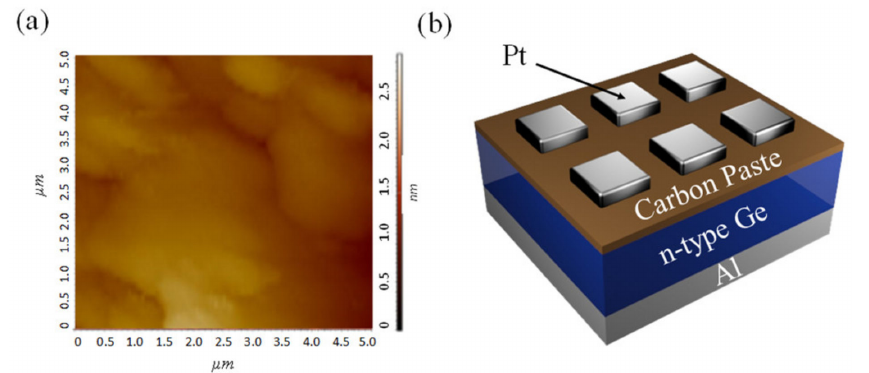
Figure 1. ( a ) Atomic force microscopy (AFM) image of a carbon paste (CP) film and ( b ) device structure of a Pt/CP/n-Ge Schottky